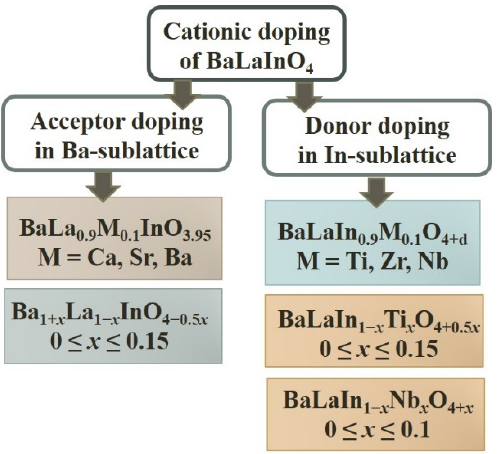
Figure 11. Scheme of acceptor and donor doping of cationic sublattices of BaLaInO 4 . The substitution of Ca 2+ , Sr 2+ , Ba 2+ - ions for La +3 ion led to the increase in the cell volumes and Ba 2+ -doped sample showed more significant increase in parameters and cell volume [76]. The ionic conductivities of the doped phases increase in the order of BaLa 0.9 Ca 0.1 InO 3.95 − BaLa 0.9 Sr 0.1 InO 3.95 − BaLa 0.9 Ba 0.1 InO 3.95 , i.e., in the order of increasing the ionic radius of dopants (Figure 12). The Nd-phase BaNdInO 4 doped with M 2+ -ions showed another trend in comparison with the BaLaInO 4 , as it was discussed